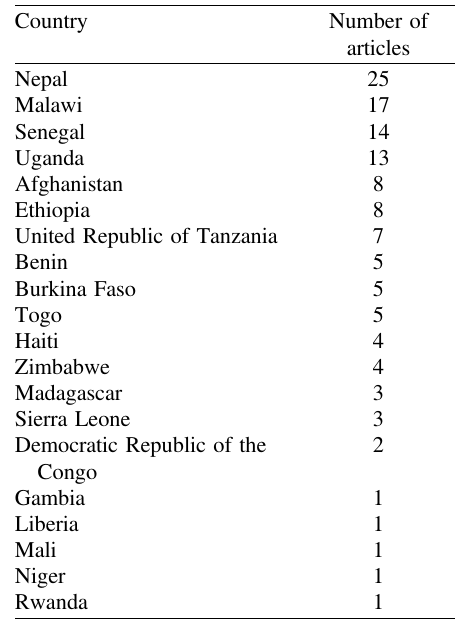
Table 3. Geographic origin of articles from low-income countries by country, 2007 –